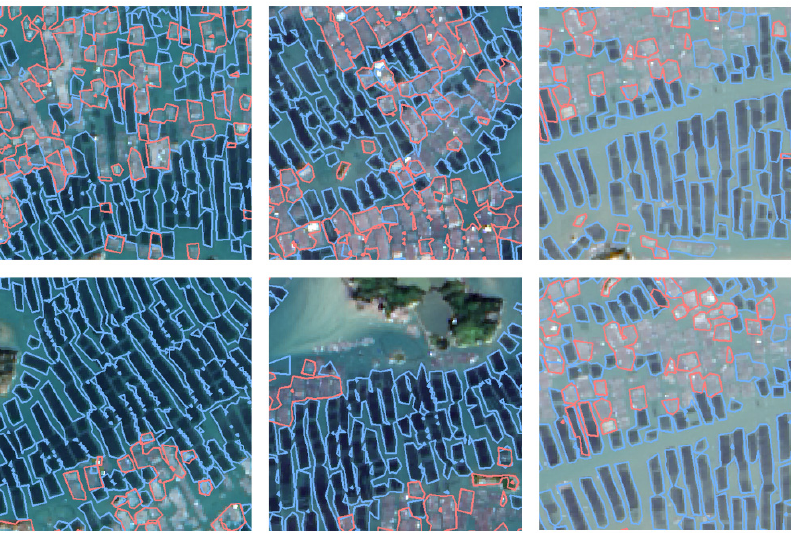
Figure 3. Extraction results of aquaculture area in Xiapu using Landsat-8 images, where the blue box represents raft culture area, and the red box represents cage culture area.